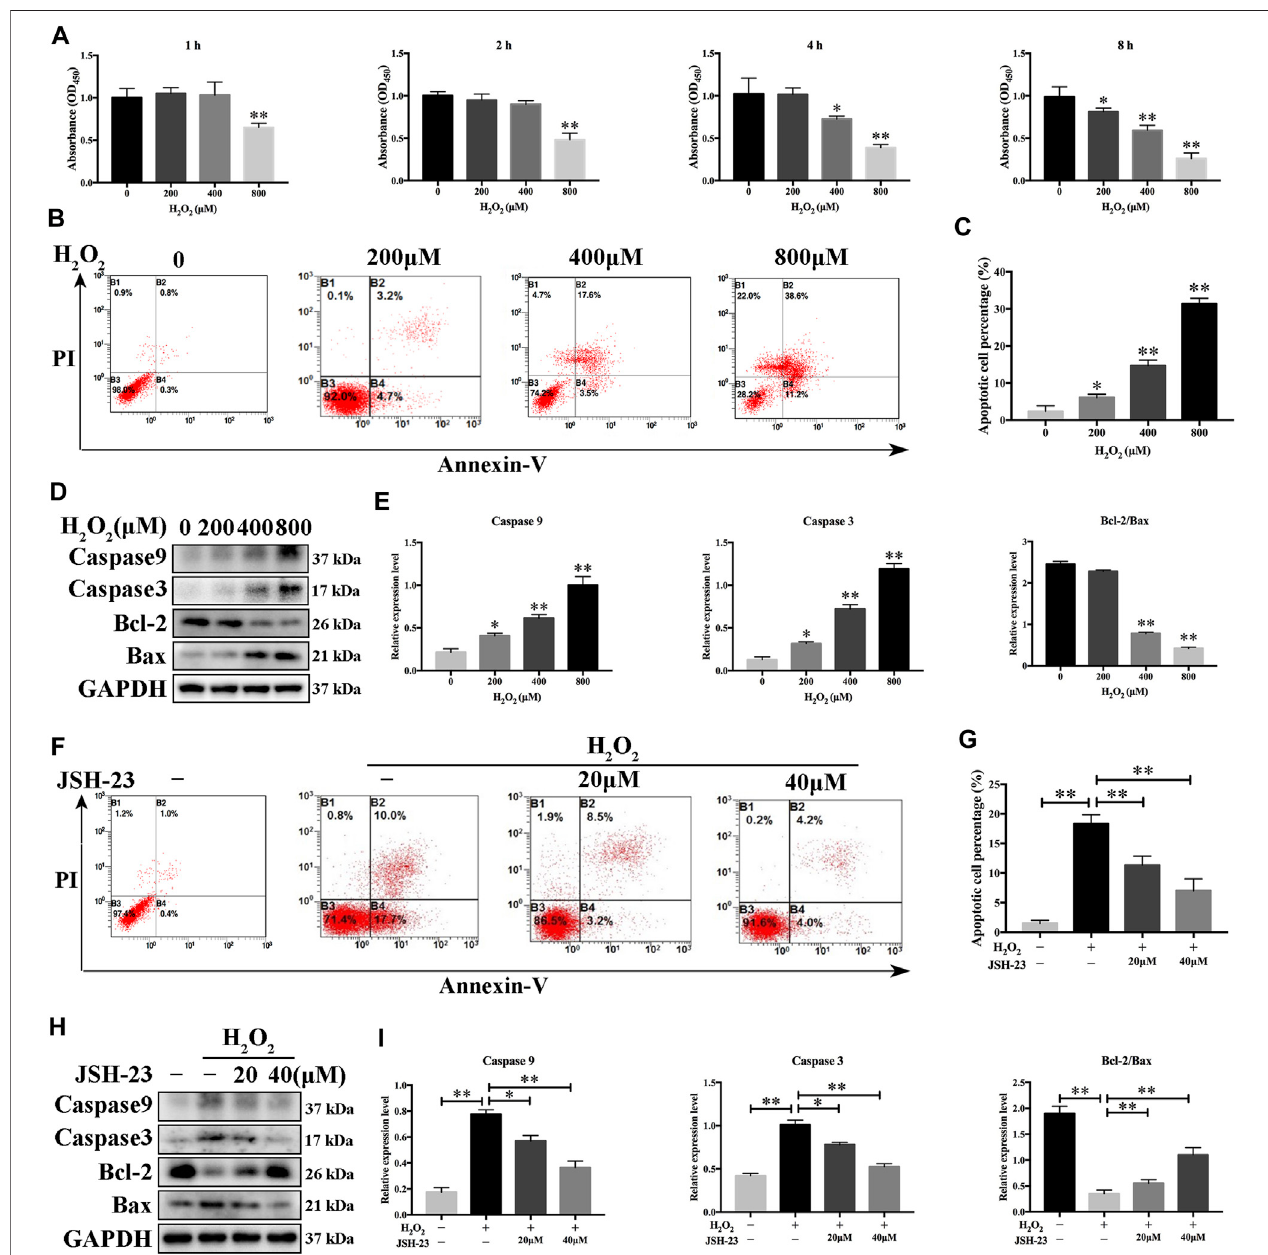
FIGURE 5 | Inhibitory effects of JSH-23 on H 2 O 2 -induced apoptosis in MC3T3-E1 cells. (A) MC3T3-E1 cells were treated with various concentrations of H 2 O 2 (0 – 800 μ M) for 1, 2, 4 and 8 h, and cell viability was analyzed by CCK-8 assay. (B) Cells were treated with 0, 200, 400 and 800 μ M H 2 O 2 for 4 h, and apoptosis was determined by fl ow cytometry followed by FITC-Annexin V and PI double staining. (C) The percentage of apoptotic cells in each well was quanti fi ed. (D – E) The protein levels of cleaved Caspase-9, cleaved Caspase-3, Bcl-2 and Bax were detected by western blotting. (F) MC3T3-E1 cells were pretreated with JSH-23 (40 μ M) for 24 handthentreatedwithH 2 O 2 (400 μ M)for4 h.Apoptosiswasmeasuredby fl owcytometryfollowedbyFITC-AnnexinVandPIdoublestaining. (G) Thepercentageof apoptosiswasdetermined. (H) Cells weretreatedfor4 hwith H 2 O 2 inthepresence orabsenceofJSH-23.Western blottinganalysiswasperformed using theindicated antibodies. (I) Quantitative analysis of the western blotting results. The values are shown as the means ± SDs, n (cid:1) 3; * p < 0.05, ** p < 0.01.